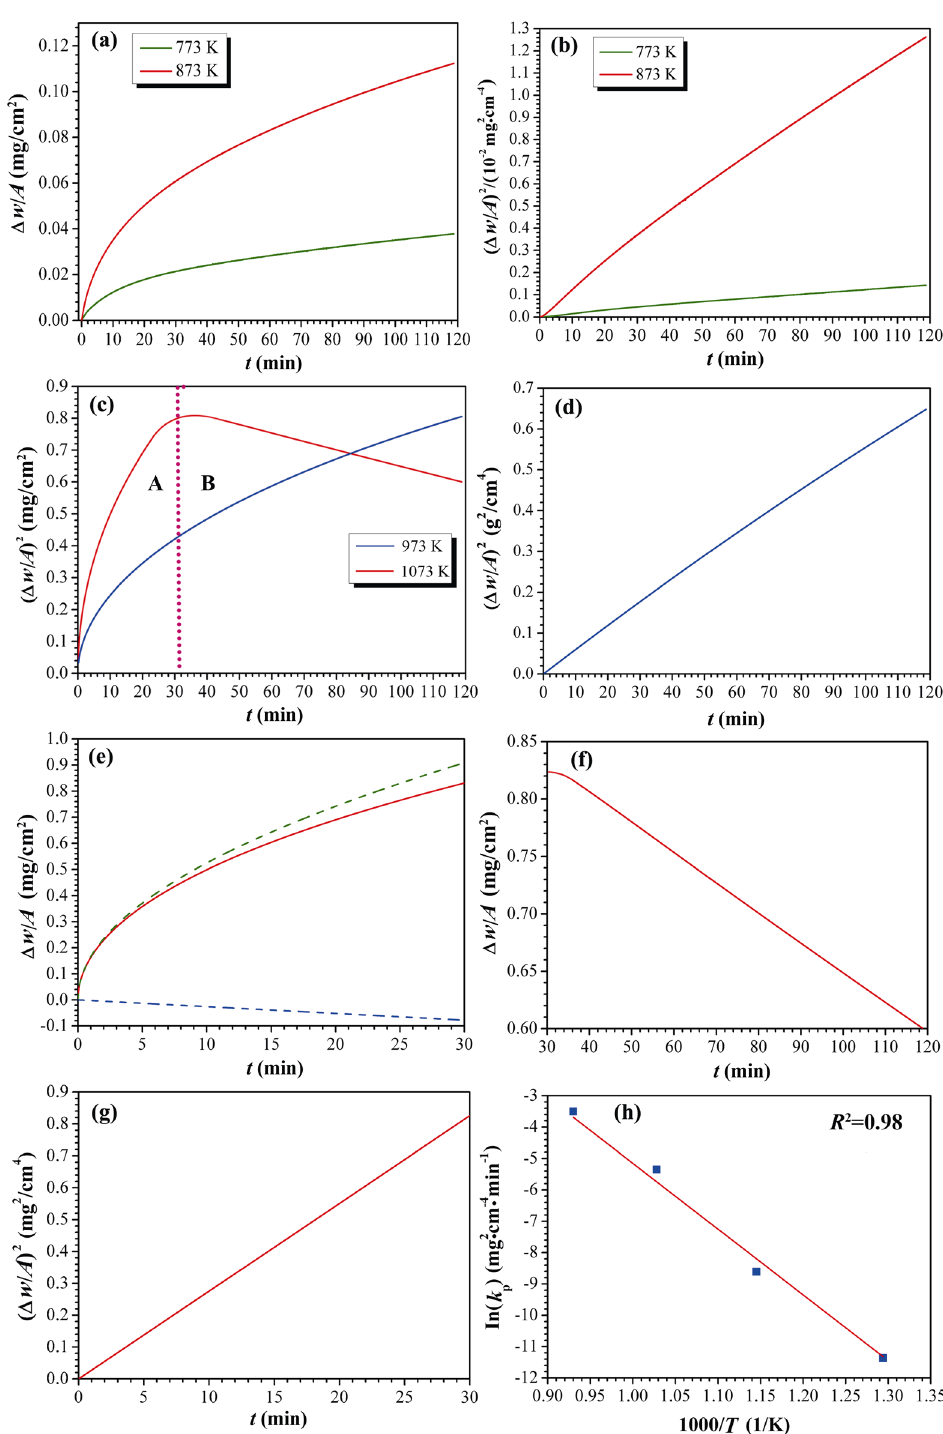
Fig. 5 Oxidation analysis of the as-synthesized HfB 2 powders by TGA tests at different temperatures: (a) weight change per unit area ( ∆ w/A , ∆ w is the weight change and A is the surface area of samples) as a function of oxidation time ( t ) at 773 and 873 K; (b) square of the weight change per unit surface area as a function of oxidation time at 773 and 873 K; (c) weight change per unit area as a function of oxidation time at 973 and 1073 K; (d) square of the weight change per unit surface area as a function of oxidation time at 973 K; (e) weight change per unit area as a function of oxidation time at 1073 K after 30 min; (f) weight change per unit area as a function of oxidation time at 1073 K before 30 min with fitted parabolic and line curves; (g) square of the weight change per unit surface area corresponding to the fitted parabolic curve in (f); (h) plot of logarithm parabolic rate k p (parabolic rate constant) versus reciprocal of the temperatures